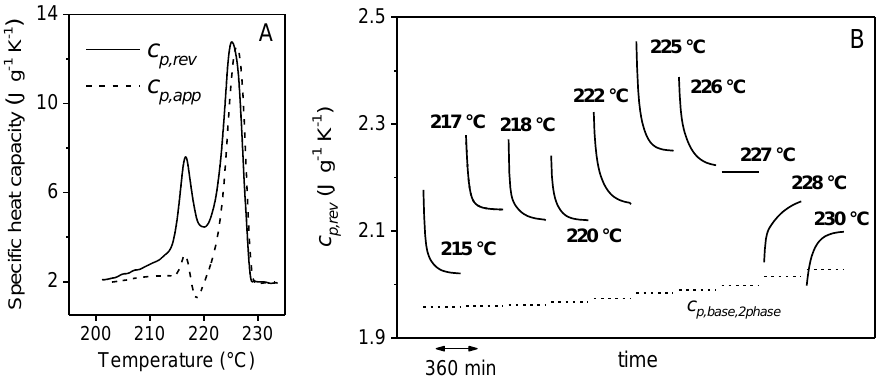
Figure 15. ( A ) Apparent specific heat capacity ( c p,app , dashed line) and reversing specific heat capacity ( c p,rev , solid line) of PBT isothermally crystallized at 200 °C for 30 min as a function of temperature during heating (heating rate: 0.5 K min −1 , modulation period: 120 s, temperature modulation amplitude: 0.2 K); ( B ) time dependence of the reversing specific heat capacity ( c p,rev ) of PBT during quasi-isothermal measurements of 6 h at the indicted T o s . The data are from separate measurements and are collected in a single graph in order to compare the c p,rev trend at different temperatures. The dashed lines are the c p,base,2phase values calculated by Equation (3) from the values of the crystallinity degrees measured at the end of the quasi-isothermal annealing, by using the solid and liquid specific heat capacities of PBT as taken from [40]. (Reprinted (adapted) with permission from [73]. Copyright (2004) American Chemical